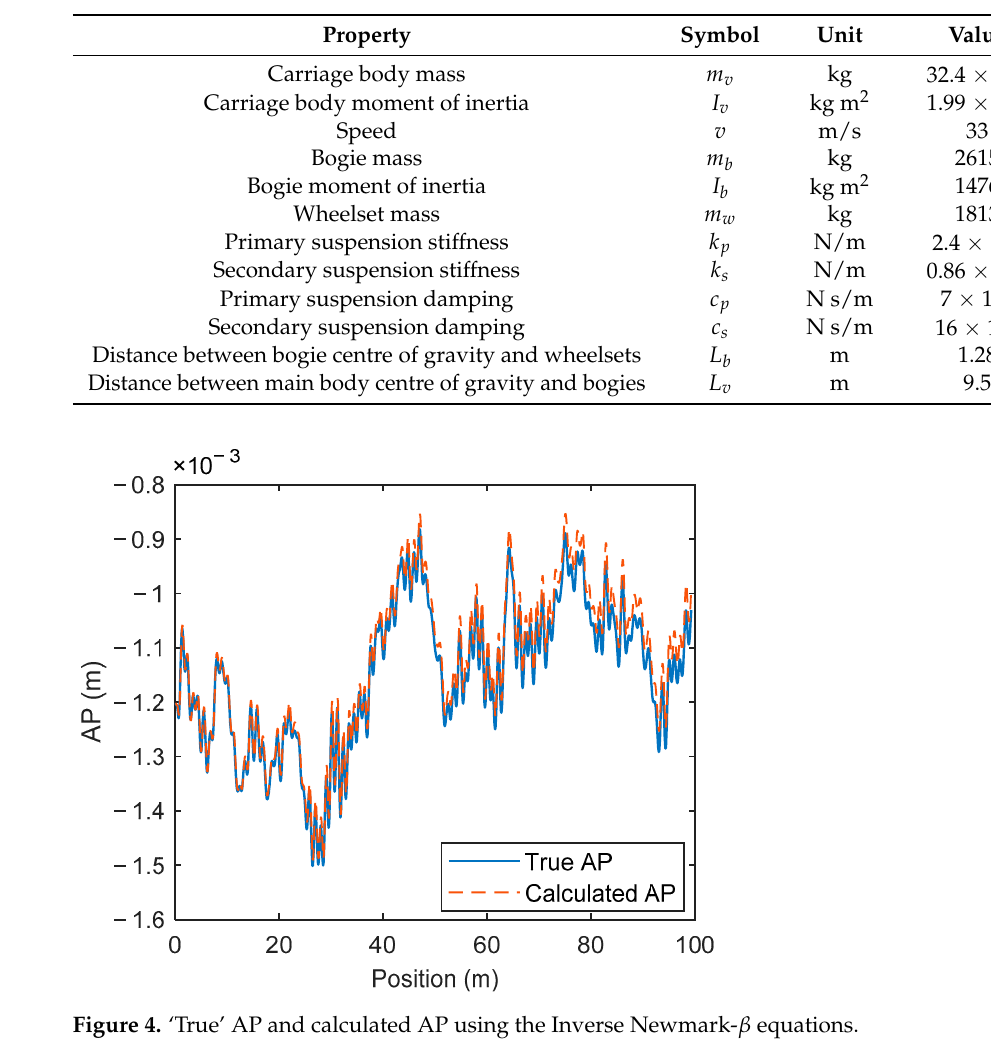
Table 1. Vehicle properties used to calculate the AP.